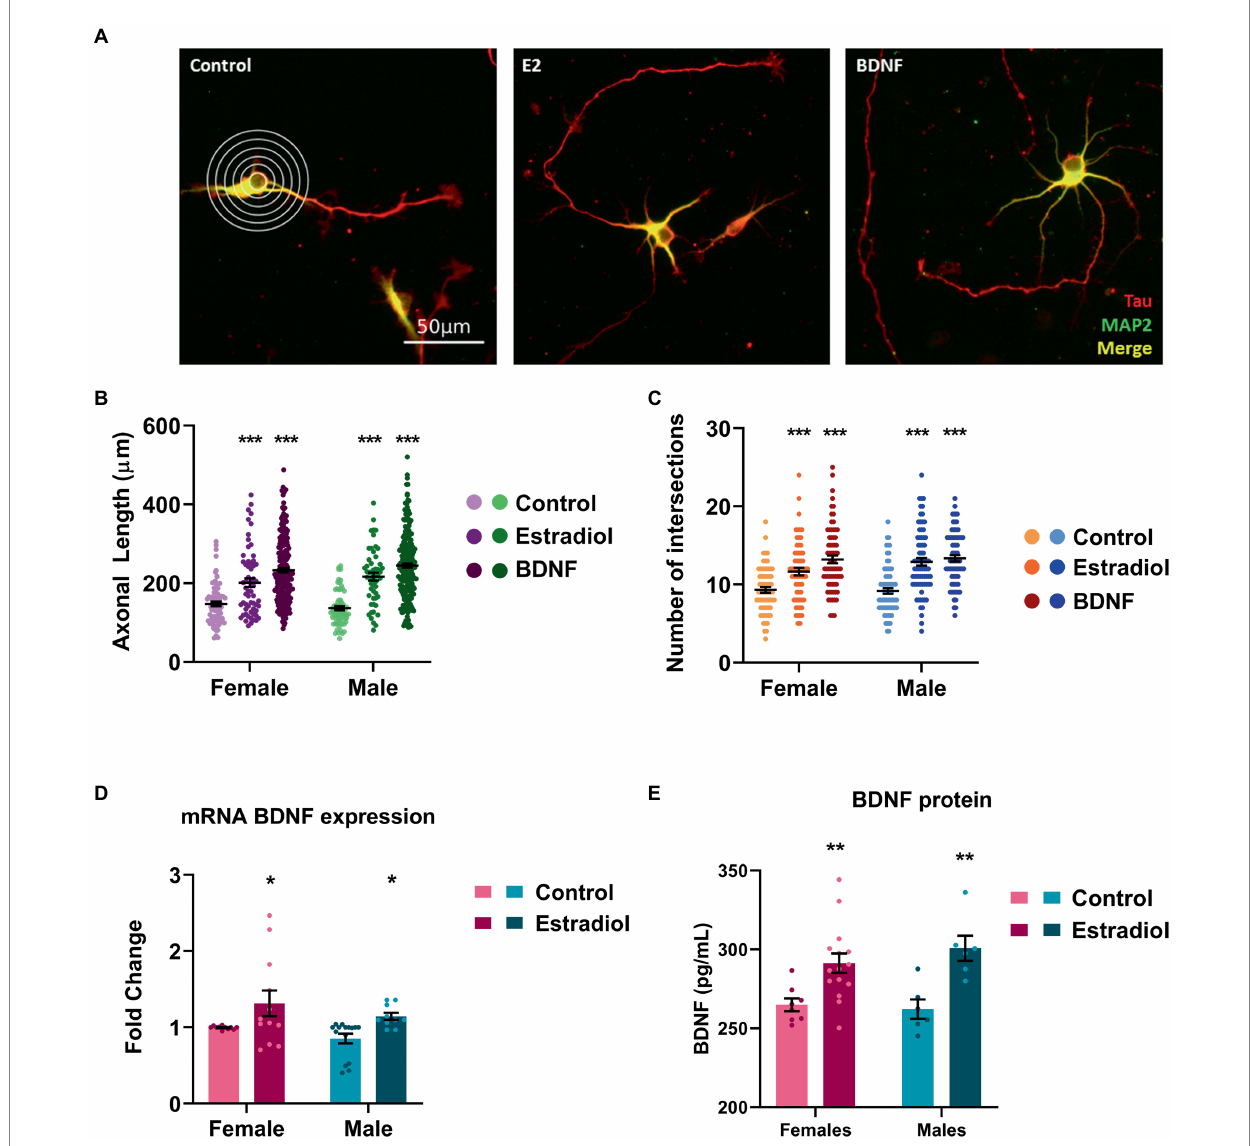
FIGURE 2 Characterization of the morphological changes induced by exogenous estradiol and BDNF in primary cultures of hippocampal neurons. (A) Representative example of four DIV neurons treated with estradiol and BDNF. In the left panel, the grid used for Sholl analysis is shown. Neurons are immunostained for MAP2 (green) and Tau (red). (B,C) Quantitative analysis of axonal length and complexity of the dendritic arbor (number of intersections of dendrites with the circles in the Sholl analysis) of sex-separated cultures treated with estradiol and BDNF. Neurons quantified (50–100) are at least from four independent experiments. Data represent the mean ± SEM; two-way ANOVA with Tukey’s multiple comparisons: *** p < 0.001 vs. control groups. (D) BDNF mRNA levels in male and female neurons treated with estradiol N ≥ 4. Data represent the mean ± SEM; two-way ANOVA with Tukey’s multiple comparisons: * p < 0.05 vs. control groups. (E) BDNF protein levels in male and female neurons treated with estradiol N ≥ 4. Data represent the mean ± SEM; two-way ANOVA with Sidak’s multiple comparisons: ** p < 0.01 vs. control